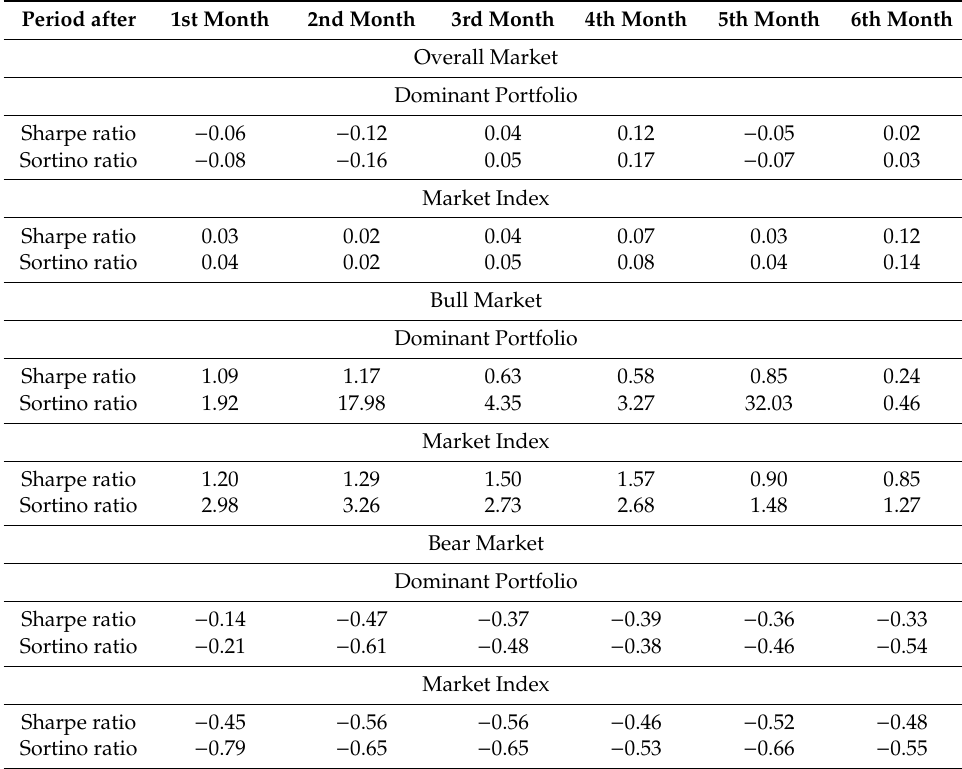
Table 2. The statistics of Sharpe and Sortino ratios for a dominant portfolio.